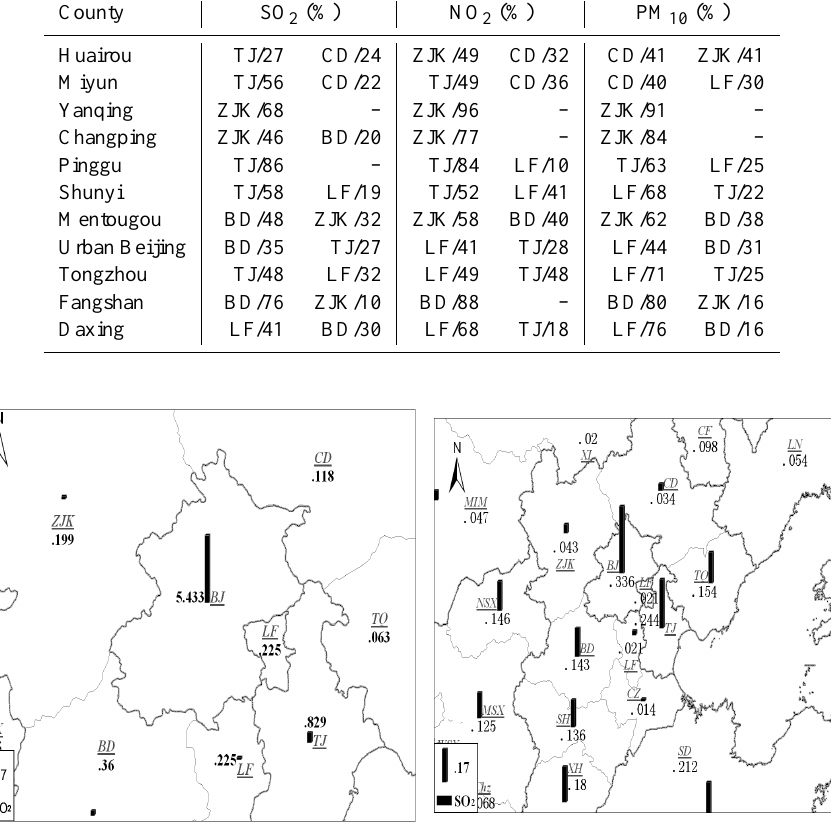
Table 6. The most important surrounding contribution to air pollution over Counties in Beijing at the surface layer. The symbol “TJ/27” means that the first important surrounding contribution to SO 2 over Huairou in Beijing is from TJ with 27% of the surrounding SO 2 concentration contribution, and the others are the similar.